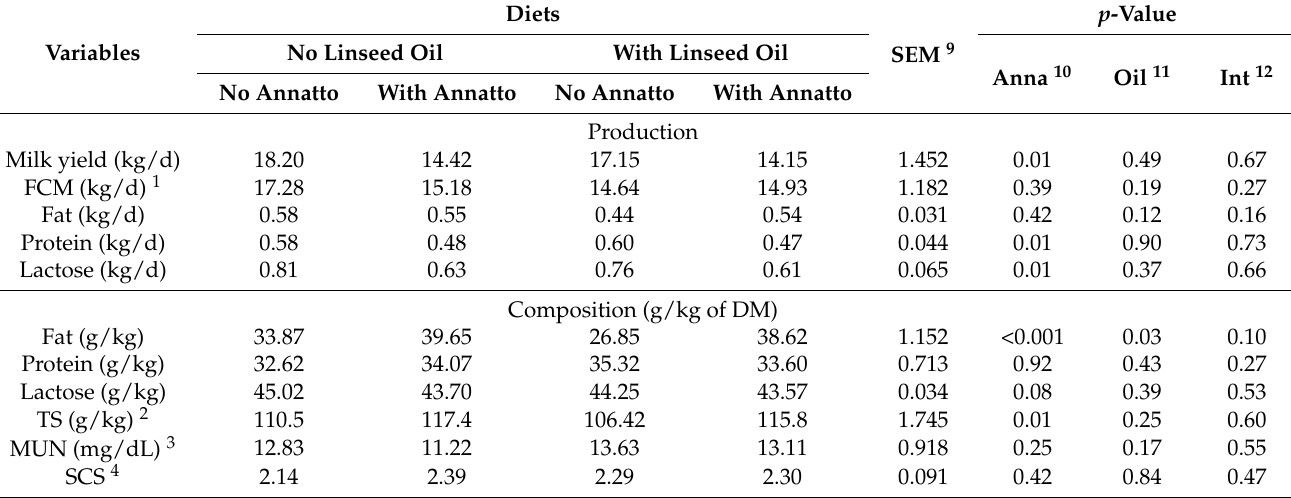
Table 3. Production, composition, oxidative profile and antioxidant activity of milk from Holstein cows feed annatto seeds and/or linseed